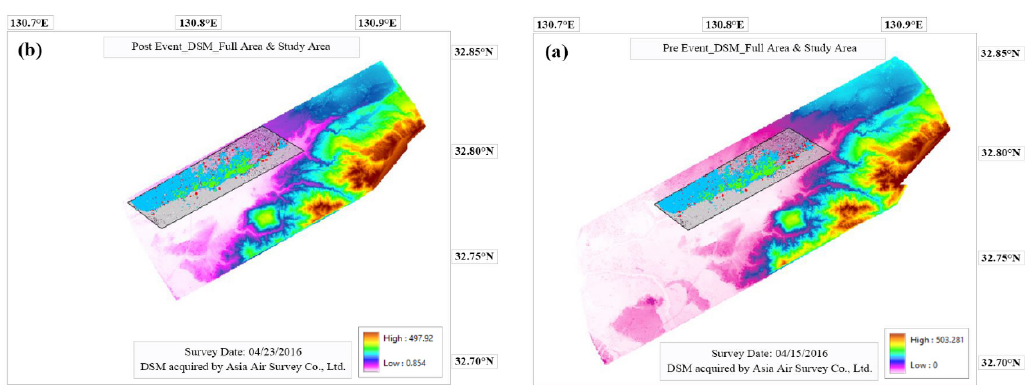
Figure 2. Location of the pre-event ( a ) and post-event ( b ) DSMs and study area. DSMs acquired by Asia Air Survey Co., Ltd. (Tokyo, Japan) [20,21]. Table 1. Registration date and other details of synthetic aperture radar (SAR) and LIDAR data.